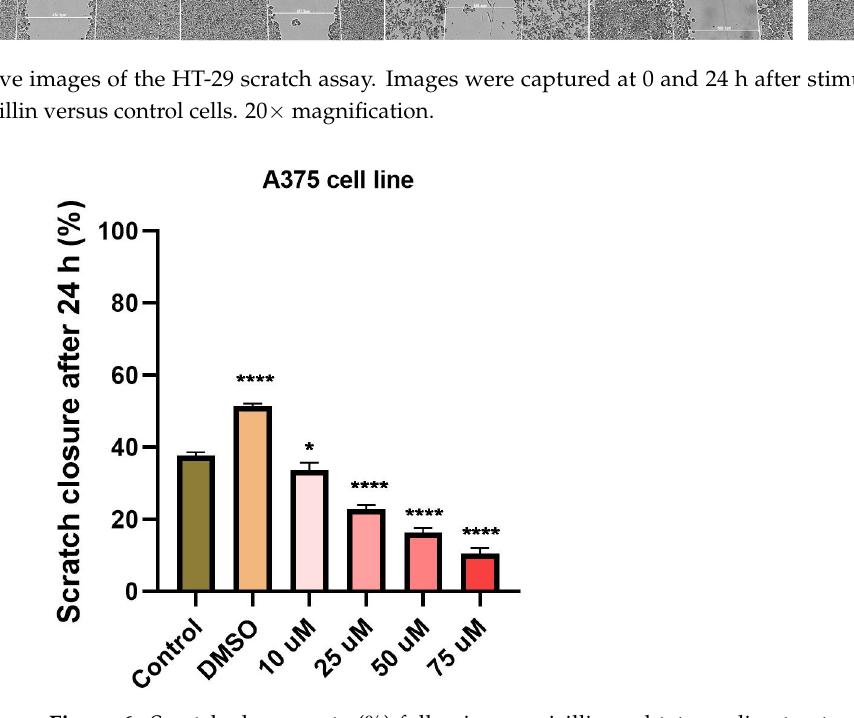
Figure 6. Scratch closure rate (%) following ampicillin and tetracycline treatment (10, 25, 50, 75, 100 µ M) measured in HT-29 cells. The graph expresses the percentage of scratch closure after 24 h compared to the initial surface. The comparison between-groups was performed using One-way ANOVA test followed by Dunnett’s post-test (* p < 0.05; **** p < 0.0001 vs. control-cells).